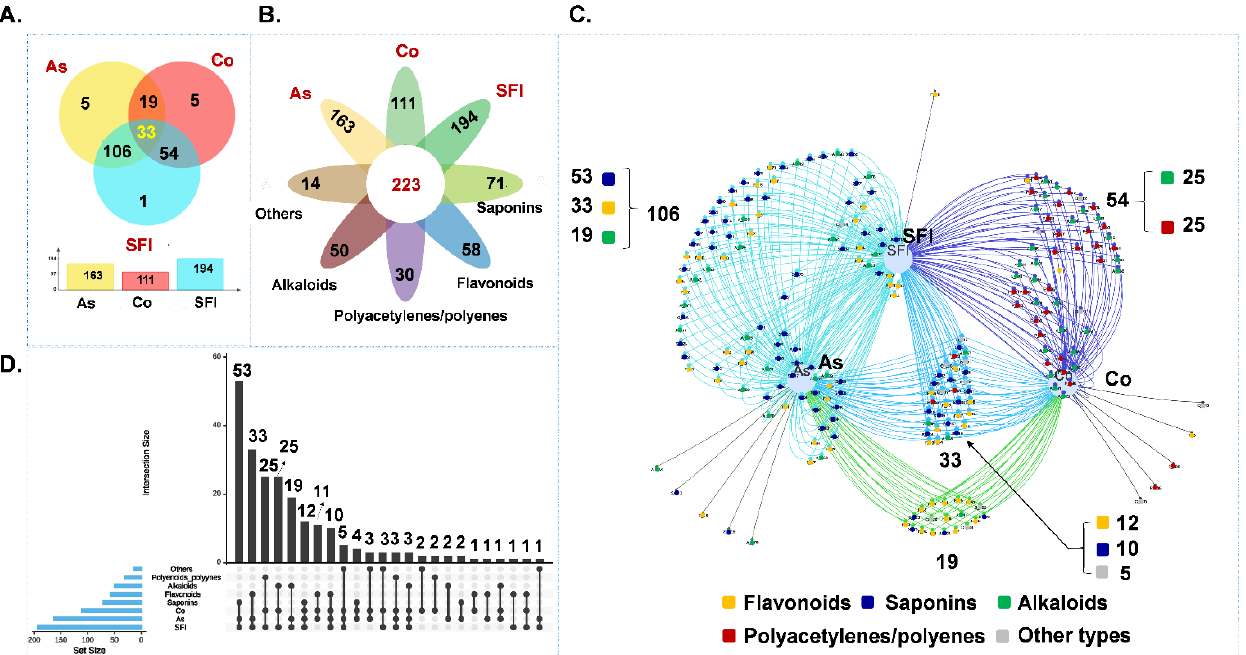
Figure 5. Various analyses show the source plants and composition of chemical components in Shenqi Fuzheng Injection (SFI). (( A ), Venn diagram of the characterized components in SFI; ( B ), flower plot of the characterized chemical compositions in SFI; ( C ), Venn network of chemical constituents in SFI; ( D ), UpSet plot of chemical constituents in SFI).